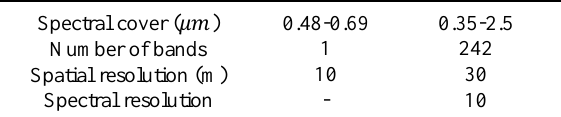
Figure 2. Flowchart of proposed